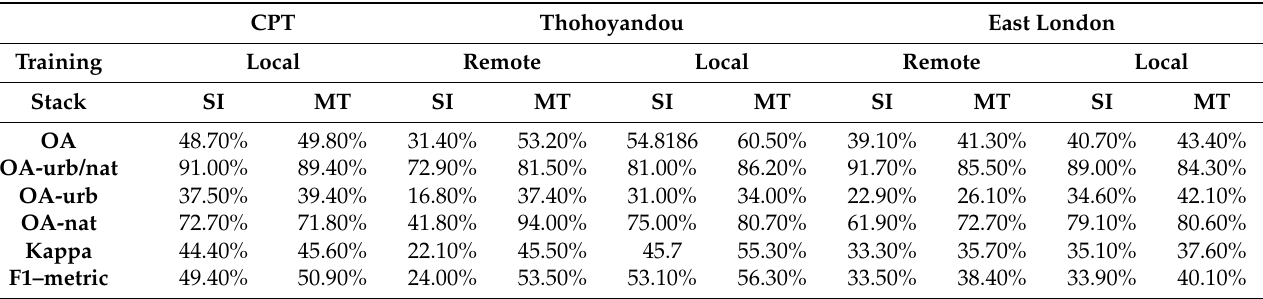
Table 5. Accuracies of single-date and multitemporal classification using remote (local to Cape Town but remote to Thohoyandou and East London) and local (standard training collected in Thohoyandou and East London).